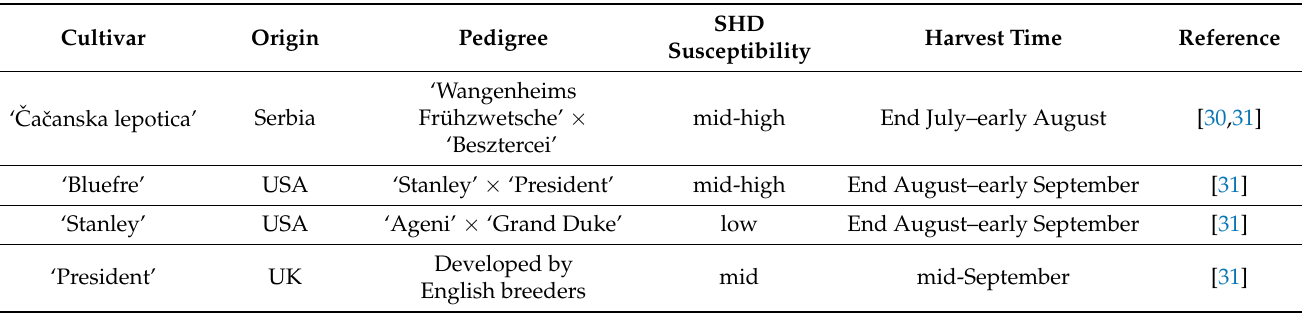
Table 1. Plum cultivar characteristics used in this study including pedigree, origin, susceptibility to shot hole disease (SHD) and harvest time in an integrated plum orchard at Debrecen-Pallag, East Hungary (2017–2019).